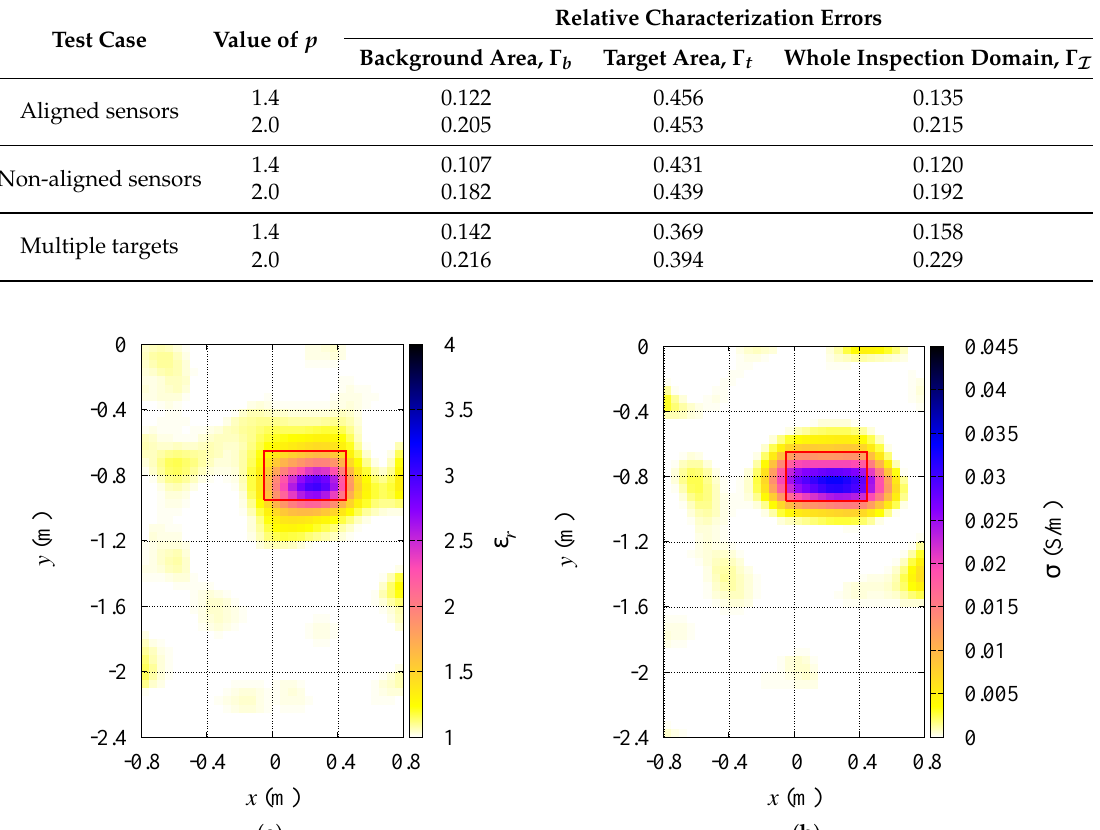
Figure 5. Non-aligned sensors. Reconstructed distributions of the ( a ) relative dielectric permittivity, and ( b ) electric conductivity of the region under test.